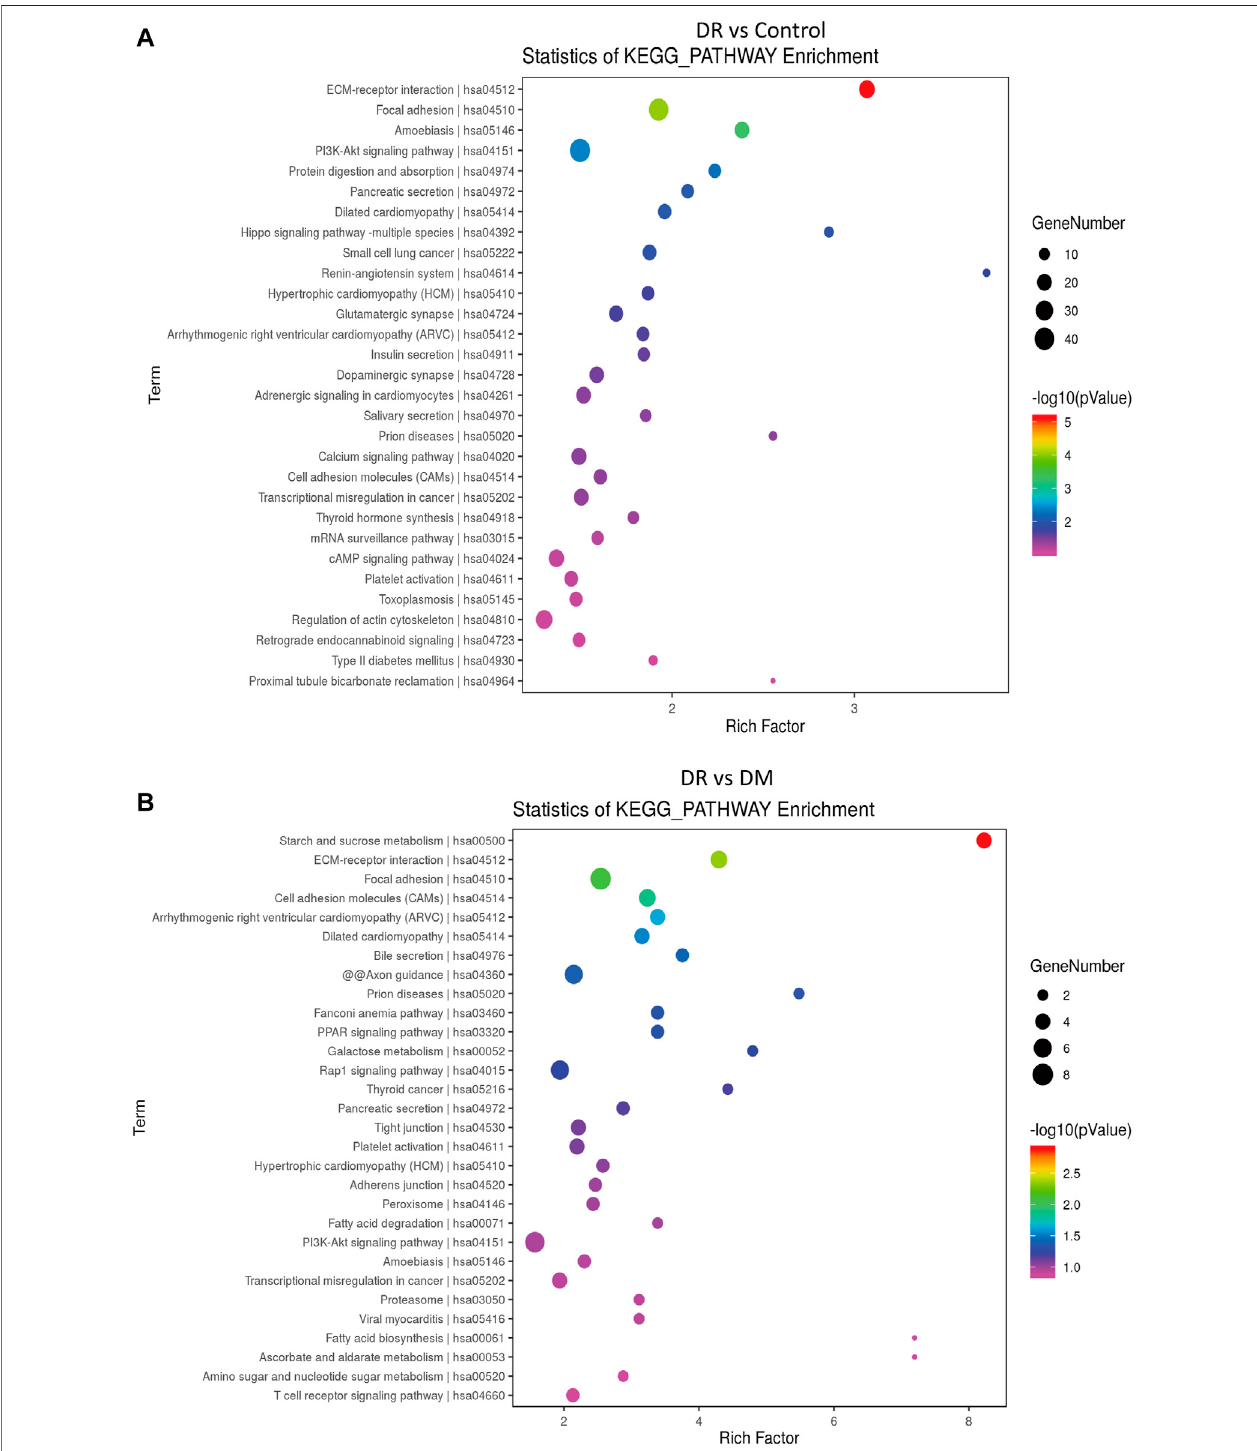
FIGURE 3 | Differentially expressed circRNAs in DR patients by KEGG analysis. (A) DR vs control group, (B) DR vs. DM group.